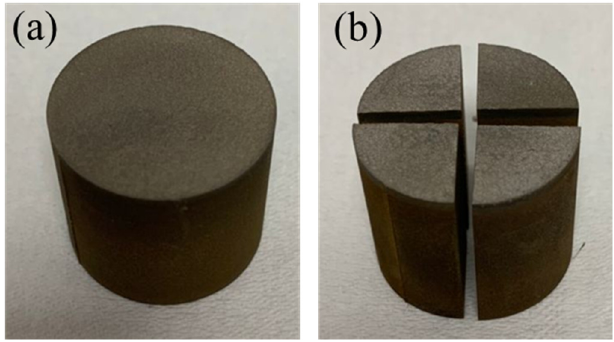
Figure 2. Cold sprayed sample ( a ) extracted from plate and ( b ) quartered using wire EDM process.